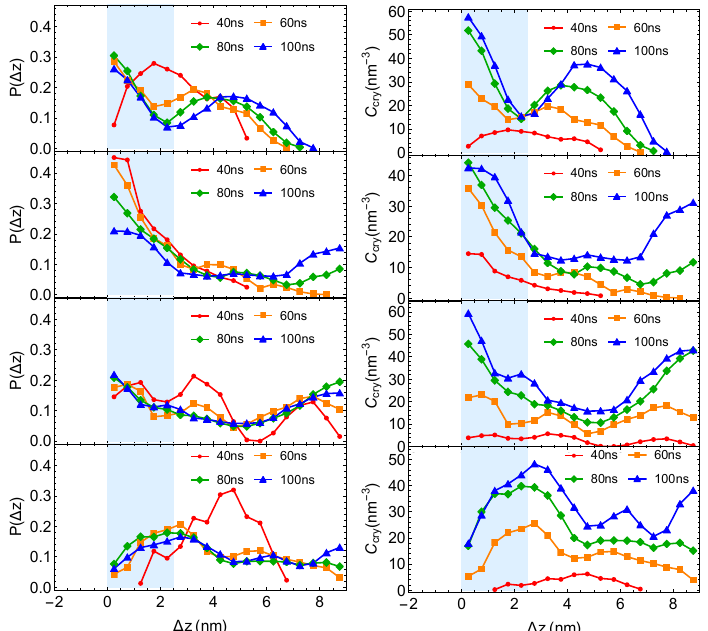
Figure A1. Crystalline atom distributions at different simulation time from four independent sim- ulations of PE a /iPP a . ( Left column ): probability distribution of crystalline atoms. ( Right column ): concentration of crystalline